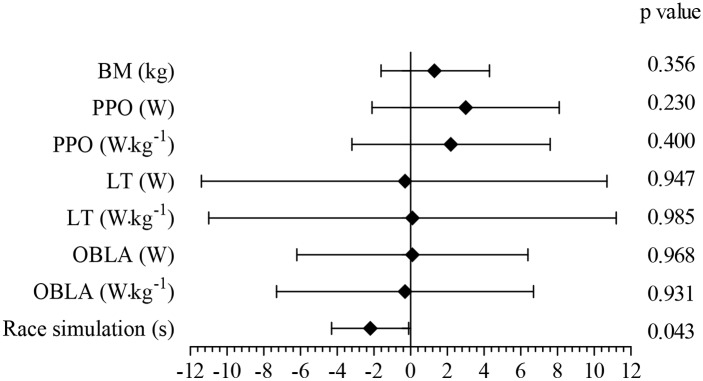
Forrest plot of percentage changes (ANCOVA) with 95% confidence intervals between HIT and SIT.The vertical zero-line represents SIT. BM—body mass; PPO—peak power output; LT—lactate threshold; OBLA—onset of blood lactate accumulation; HIT—high-intensity aerobic interval training; SIT—sprint interval training; Δ %—percentage change.